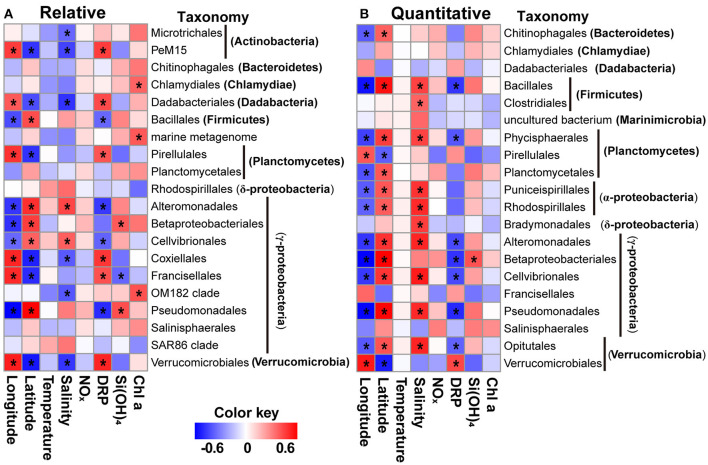
Heatmaps showing significant correlations between specific orders (A,B) of bacteria and environmental variables (e.g., temperature, salinity, nutrients, and Chl a) and geographic factors for relative and quantitative abundances using a sparse partial least squares approach. The orders present in all samples were used. Significant correlations (|r| > 0.5) are labeled with asterisks. NOx, nitrite + nitrate; DRP, dissolved reactive phosphorus.